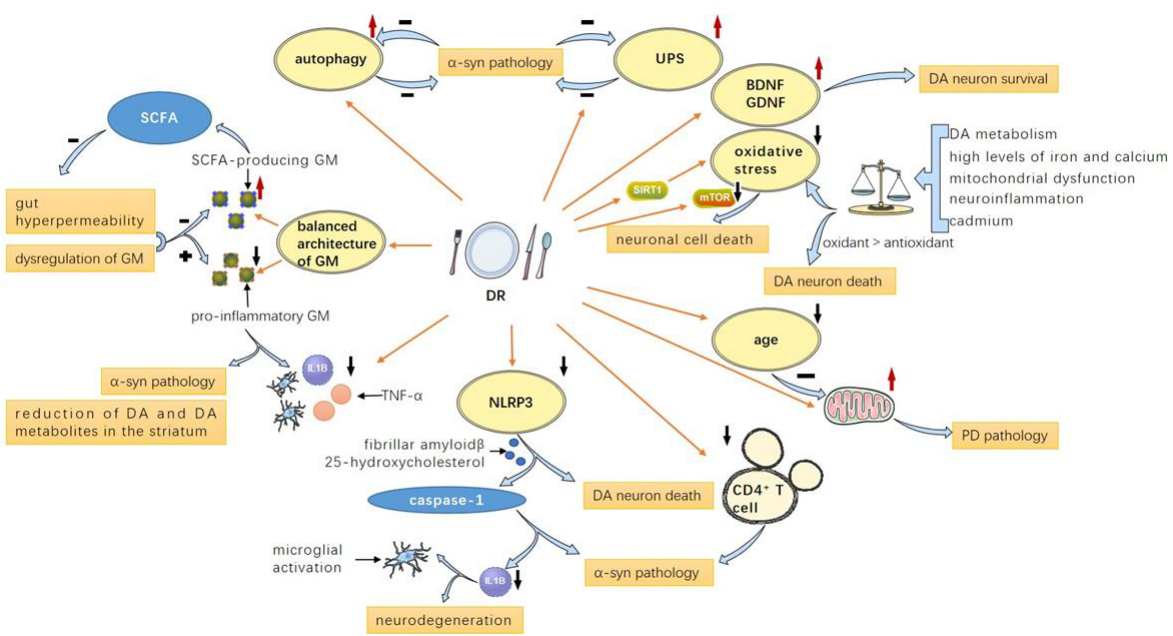
Figure 2. Possible mechanisms of DR on PD: DR contributes to a balanced architecture of GM con- sisting of more SCFA-producing GM and less pro-inflammatory GM, as the former leads to less gut hyperpermeability and the latter leads to increased inflammatory factor levels, α -synuclein pathology, and reduction in DA and DA metabolites in the striatum; DR attenuates NLRP3 inflammasome and CD4+ T cells, leading to reduced α -syn pathology and caspase-1 and IL- 1β lev- els, which could promote microglial activation and neurodegeneration; DR also delays aging and enhances mitochondrial function, thus ameliorating PD pathology; DR suppresses oxidative stress by modulating mTOR and SIRT1-related pathways and boosts the level of neurotrophic factors like BDNF and GDNF; DR enhances autophagy and UPS to facilitate α -synuclein degradation, thus ameliorating α - synuclein pathology. PD: Parkinson’s disease; SCFA: short-chain fatty acid;